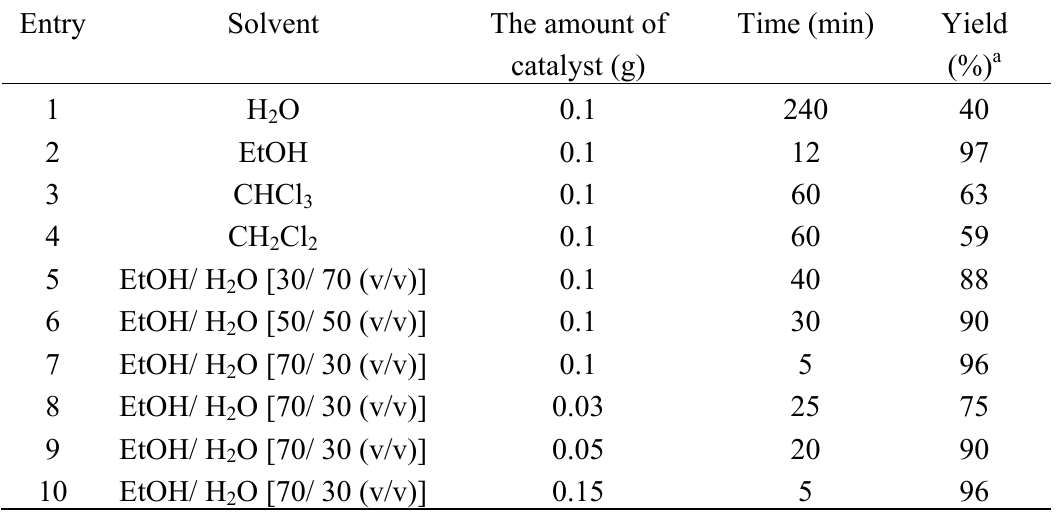
Table 1 . The influence of the solvent on the condensation reaction of o